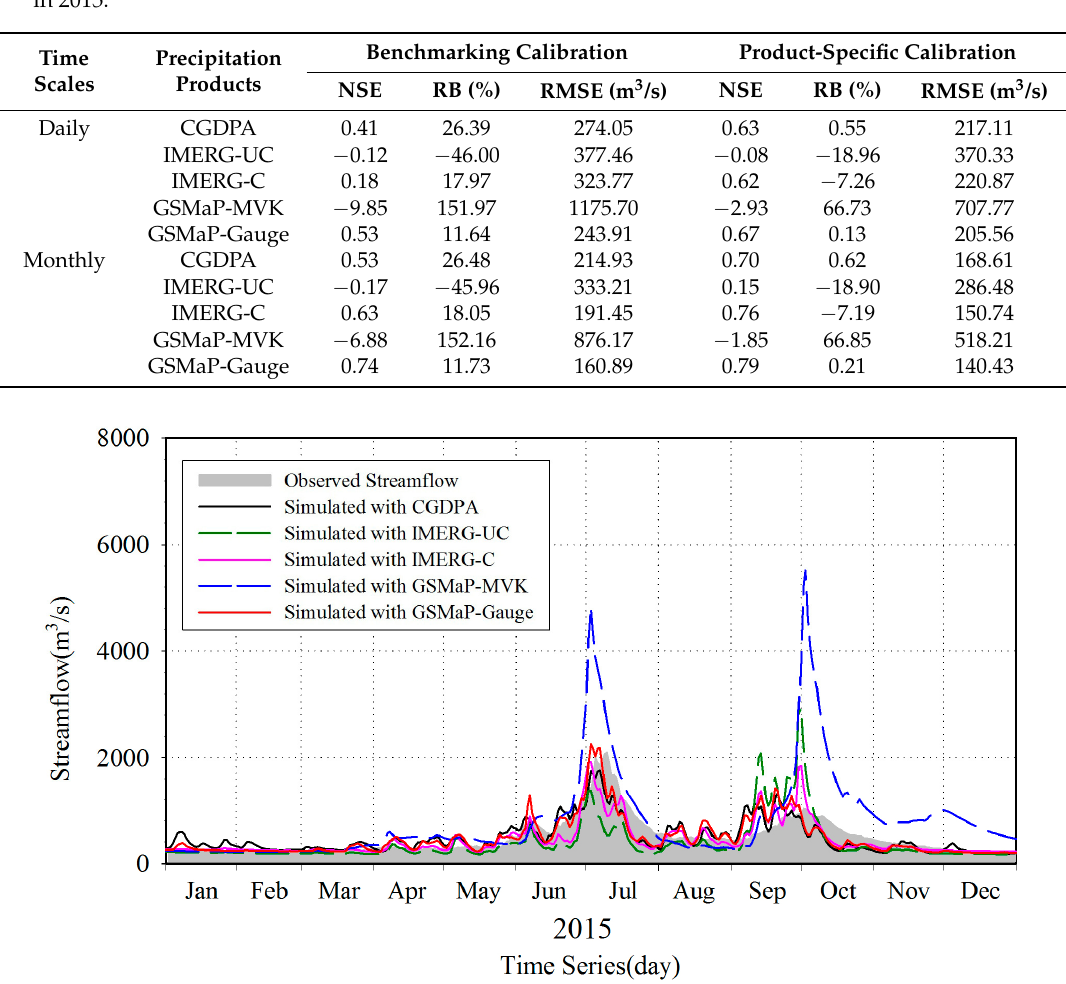
Figure 11. Comparison of VIC simulated streamflow with recalibrated parameters using product- specific inputs.